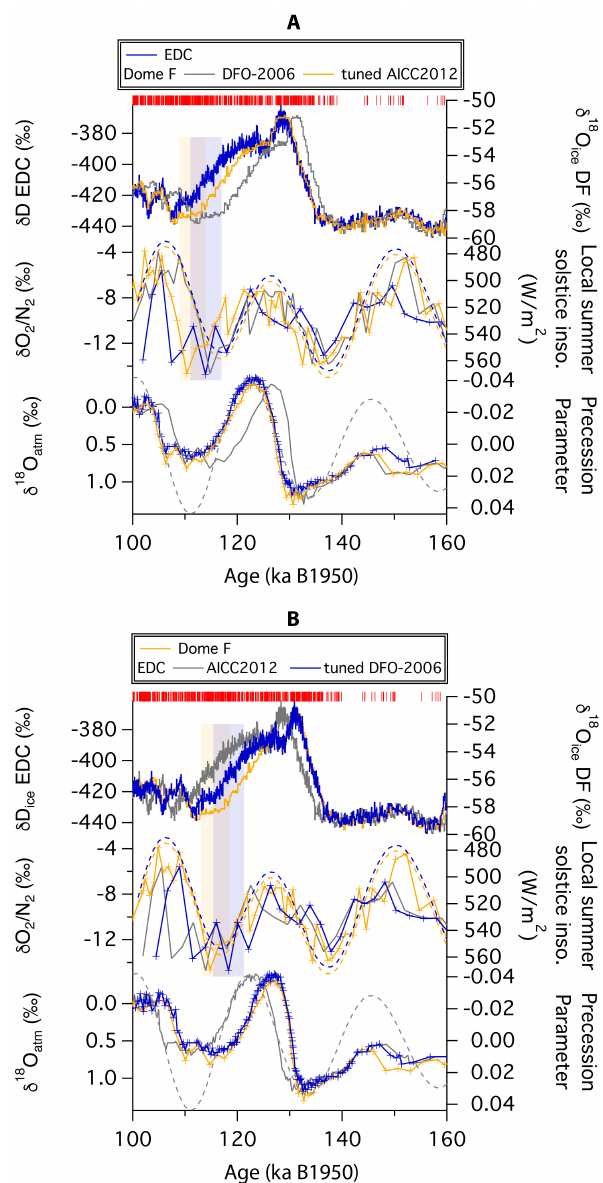
Figure B1. EDC and Dome F synchronization using the volcanic matching of Fujita et al. (2015). (a) : transfer of Dome F records on AICC2012, (b) : transfer of EDC records on DFO-2006 us- ing the volcanic tie points of Fujita et al. (2015). The coloured curves represent EDC and Dome F records tuned together on either chronologies. The grey curves correspond to the data on their origi- nal chronology, before tuning. Top: δ D record of EDC and δ 18 O ice record of Dome F. Middle: δ O 2 / N 2 records and local summer sol- stice insolation. Bottom: δ 18 O atm records and precession parame- ter shifted by 5ka. The yellow and blue shaded area highlight the relative position of δ O 2 / N 2 minima (uncertainty range) within the water isotopic composition records. The volcanic tie points are in- dicated by the red markers on top of the